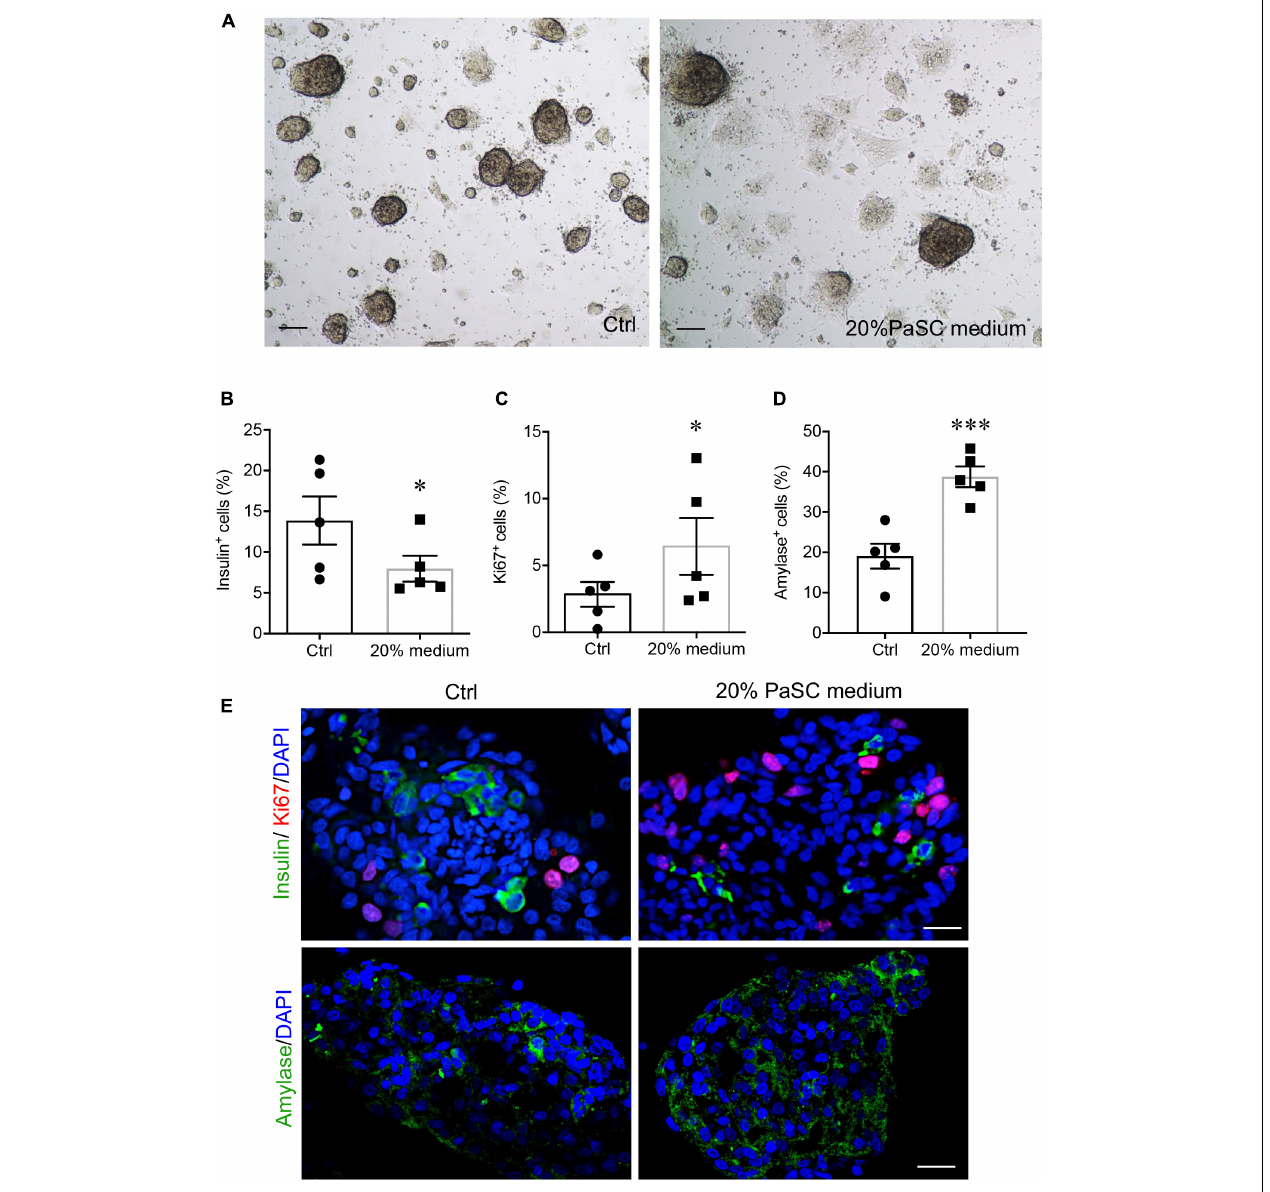
FIGURE 7 | PaSC-conditioned medium enhances exocrine cell differentiation during hIECC culture. (A) Bright-field images of hIECCs cultured with or without 20% PaSC-conditioned medium for 48 h. Scale bar: 100 µ m. The percentage of insulin + (B) , Ki67 + (C) and amylase + (D) cells in hIECCs. Closed circles, control; closed squares, 20% PaSC medium. Data are expressed as mean ± SEM ( n = 5 experiments/treatment group). ∗ p < 0.05, ∗∗∗ p < 0.001; analyzed using paired Student’s t -test. (E) Representative immunofluorescence staining images for insulin or amylase (green) and Ki67 (red), and the nuclear stain DAPI (blue). Scale bar: 25 µ